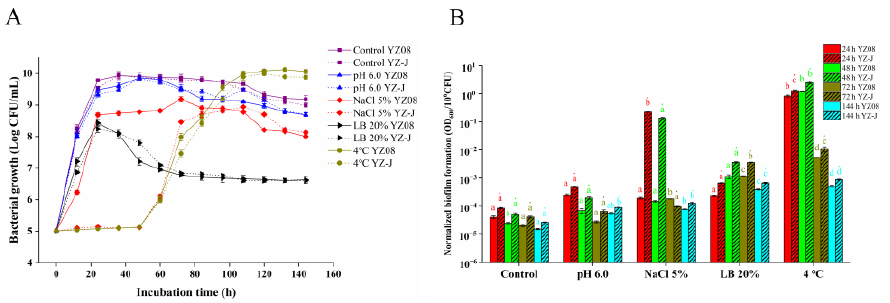
Figure 4. Growth curves ( A ) and biofilm formation ( B ) for Shewanella putrefaciens YZ08 and YZ-J under different stress conditions. The significance analysis of the same strain under different stress conditions at the same culture time was conducted; different lowercase letters indicate a significant difference ( p < 0.05, the different styles of letters are used to distinguish the different groups).